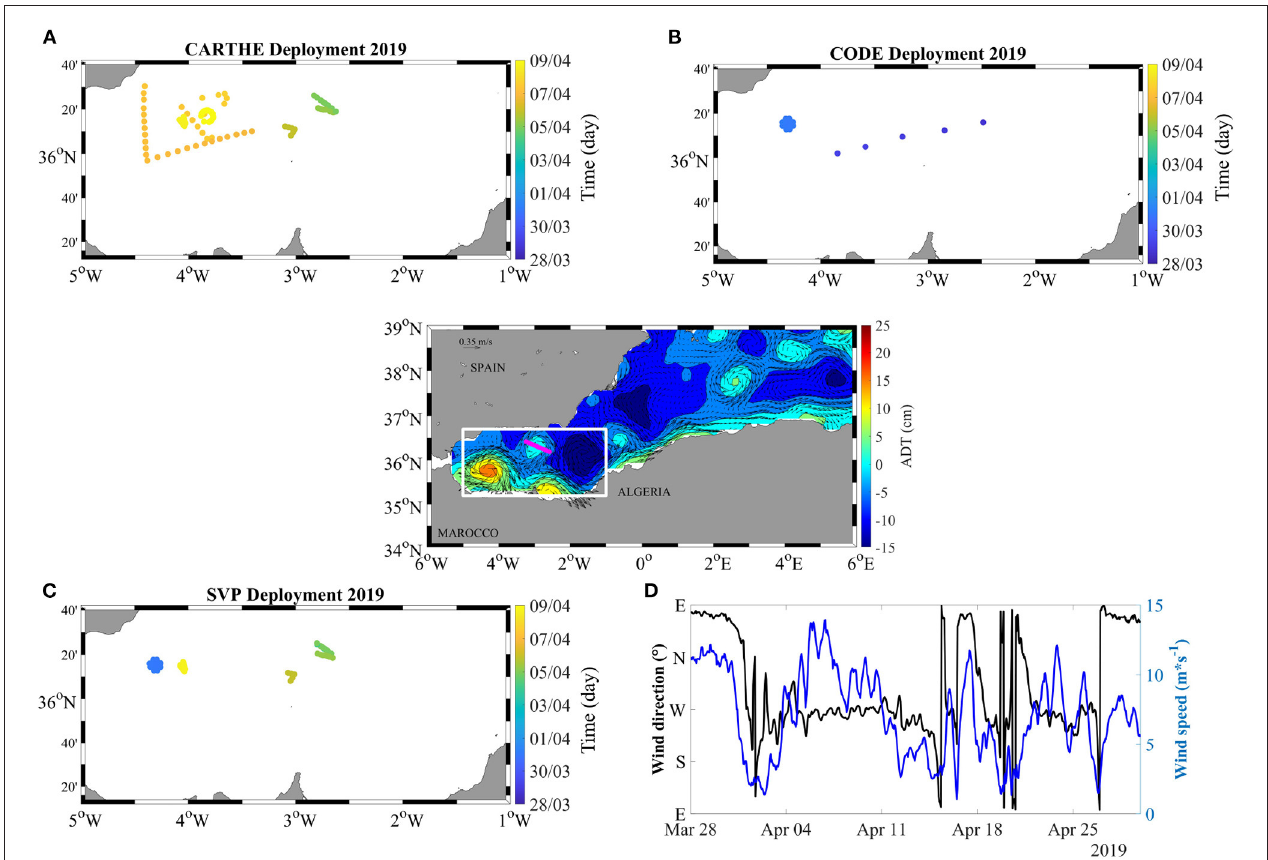
FIGURE 2 | Central panel: mean ADT (units in cm) and surface geostrophic current (black arrows) in the Alboran Sea from March 28 to April 29, 2019. The white box indicates the area of drifter deployments, the magenta line represents the position of the UCTD transect shown in Figure 4 . The inserts (A–C) show the color coded deployment sequence of CARTHE, CODE, and SVP. Panel (D) shows the wind speed (blue) and direction (black) time series, averaged over the white box coverage in the central